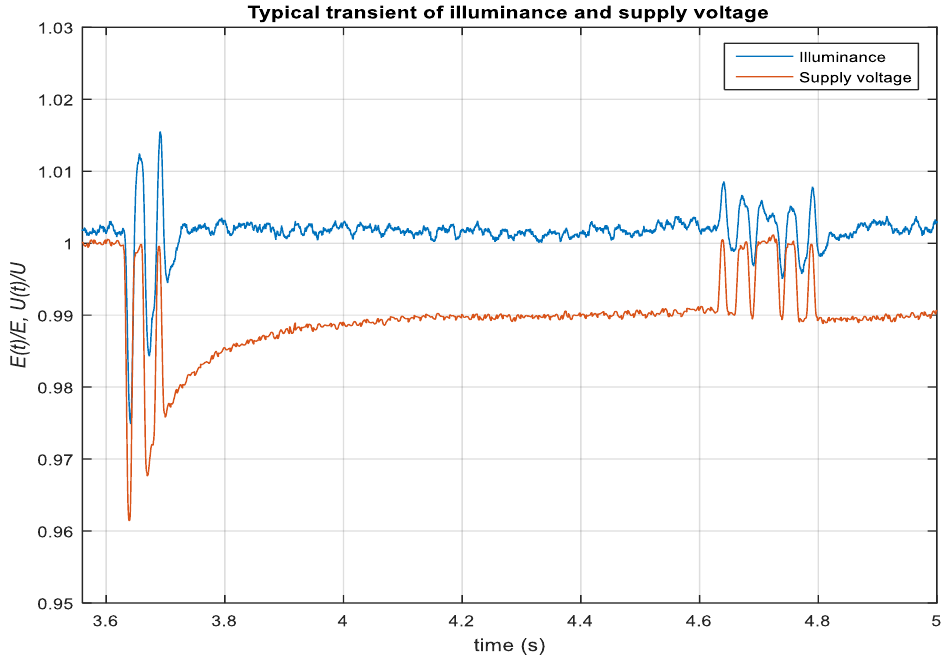
Figure 3. Normalized RMS values of supply voltage and illuminance of an LED luminaire.